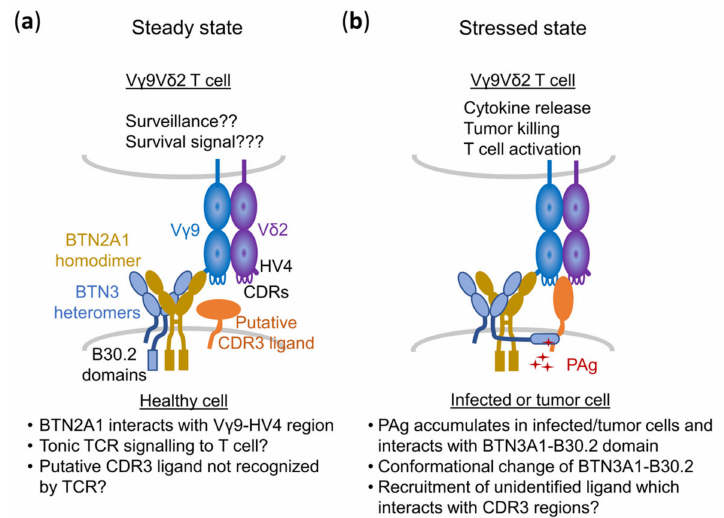
Figure 6. Composite ligand model of PAg sensing by the V γ 9V δ 2 TCR. ( a ) Steady state: A